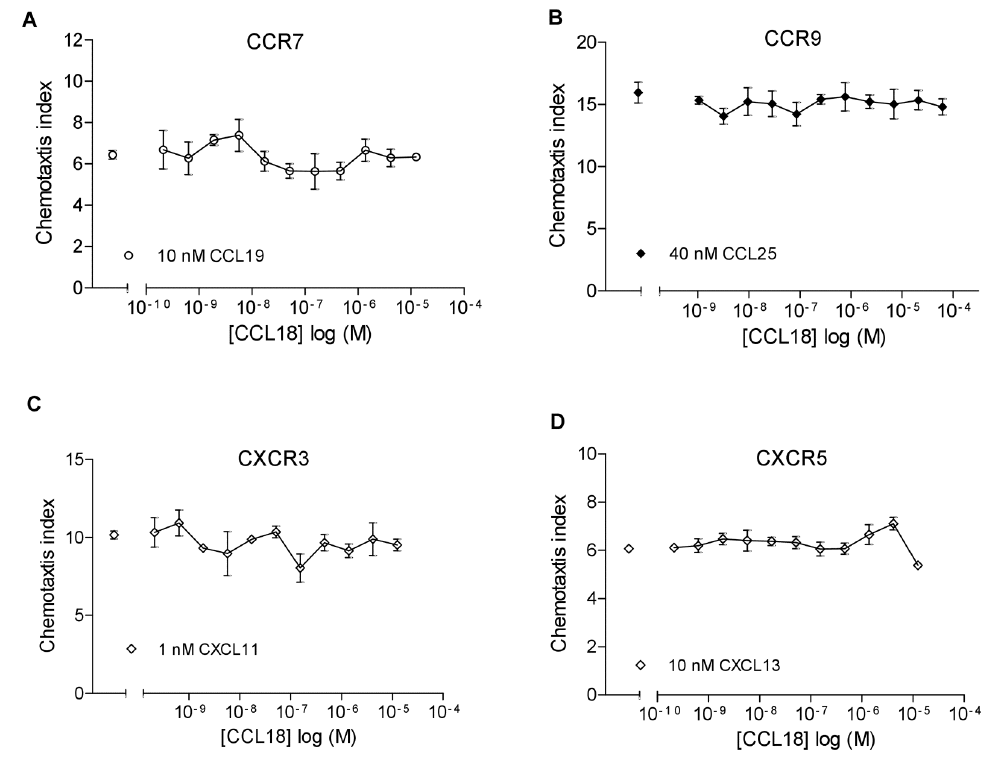
Figure 4. CCL18 does not have an inhibitory effect on CCR7, 9, CXCR3 and 5-mediated chemotactic responses. Inhibition of chemotaxis assay of A) 10 nM CCL19 mediated chemotactic response of T lymphocytes. One representative experiment out of two is shown. B) 40 nM CCL25 mediated chemotactic response of MOLT-4. One representative experiment out of four is shown.